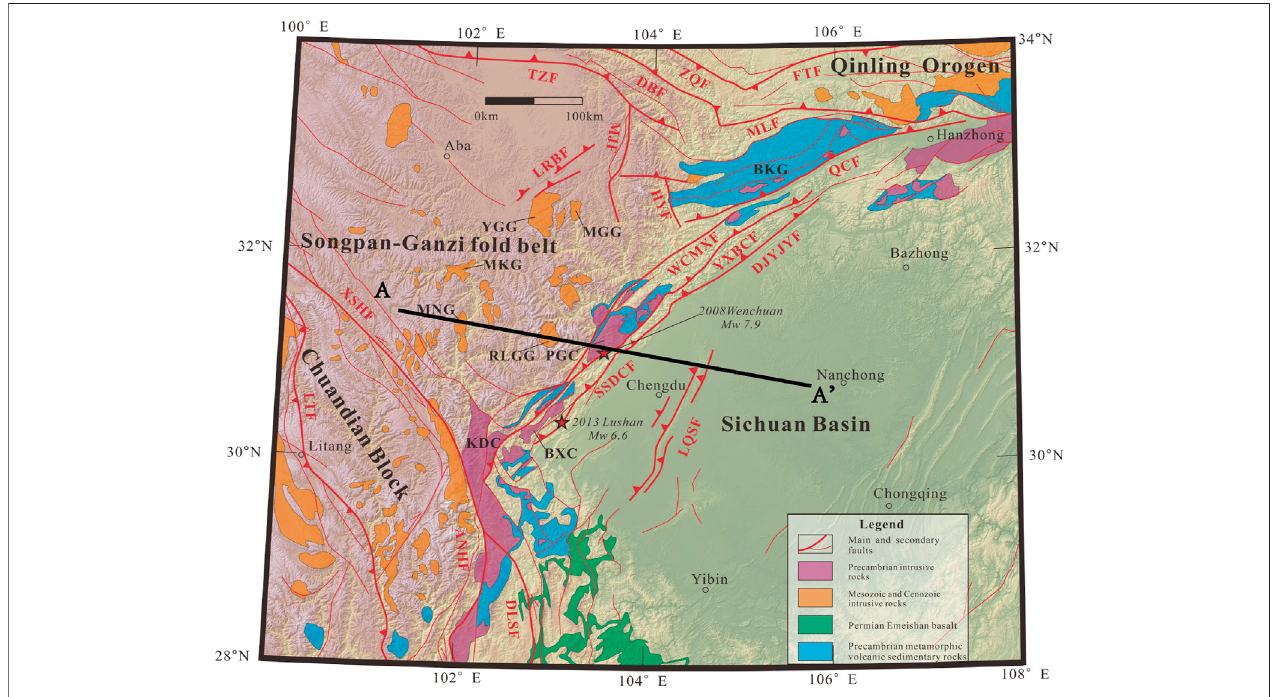
FIGURE1| GeologicalsketcharoundLFZ.Themainand secondary faults aredrawnbythickand thinblacklines,respectively.Types ofrock outcrops aregivenin the legend. The two stars show the location of the 2008 Ms8.0 Wenchuan and the 2013 Ms7.0 Lushan earthquake in the LFZ. The black solid line AA ′ marks the pro fi le shownin Figure10 .Abbreviationsareasfollows:TZF,TazangFault;DBF,DiebuFault;ZQF,ZhouquFault;MLF,MianlueFault;FTF,FengtaiFault;LRBF,LongribaFault; MJF,MingjiangFault;HYF,HuyaFault;QCF,QingchuanFault;WCMXF,Wenchuan-MaoxianFault;YXBCF,Yingxiu-BeichuanFault;DJYJYF,Dujiangyan-Jiangyou Fault; XSHF, Xianshuihe Fault; SSDCF, Suangshi-Dachuan Fault; LQSF, Longquanshan Fault; LTF, Litang Fault; ANHF, Anninghe Fault; DLSF, Daliangshan Fault; BKG, Bikou Group; PGC, Pengguan Complex; BXC, Baoxing Complex; KDC, Kangding Complex; YGG, Yanggon Granite; MGG, Maoergai Granite; MKG, Markam Granite; MNG, Manai Granite; RLGG: Rilongguan Granite. The geological base map is modi fi ed from Ren et al. (2013). The faults and granites are named according to Zhang et al. (2008c), Bai et al. (2018), Roger et al. (2004) and Zhang et al. (2006).